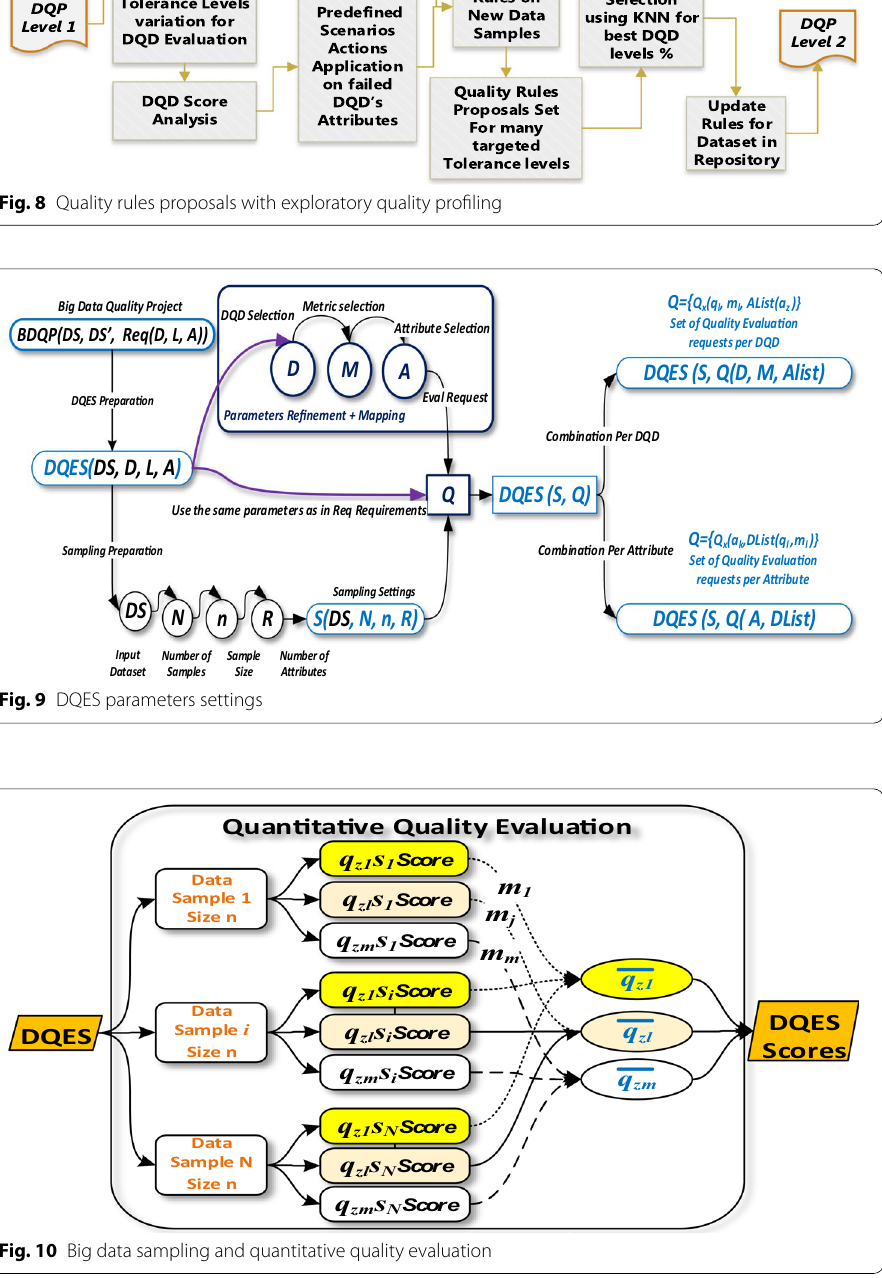
(d) Quality rules optimization: The Quality Rules execution consists of pre-processing